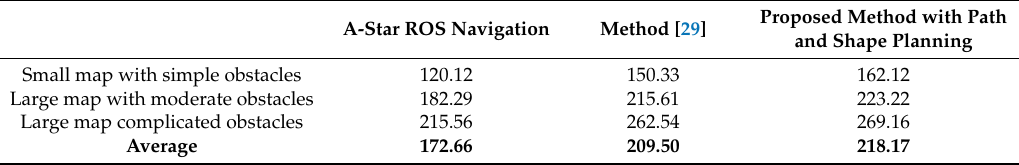
Table 3. The running comparisons of areas coverage (s).